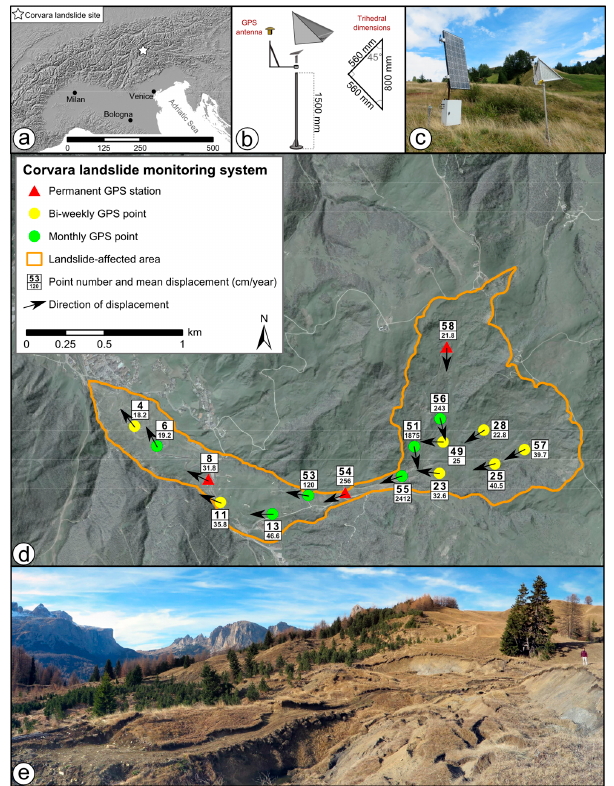
Figure 1. Corvara landslide: ( a ) Landslide location; ( b ) geometric features of the X-Band Corner Reflectors (CR) and detail of the trihedral faces; ( c ) permanent Global Position System (GPS) monitoring site with X-band CR; ( d ) outlines of the landslide-affected area, monitoring system and mean annual displacements (September 2013–September 2015) measured by DGPS (background: 2.5 m DTM and 2011 orthophoto); and ( e ) field impressions from a highly active section north of point